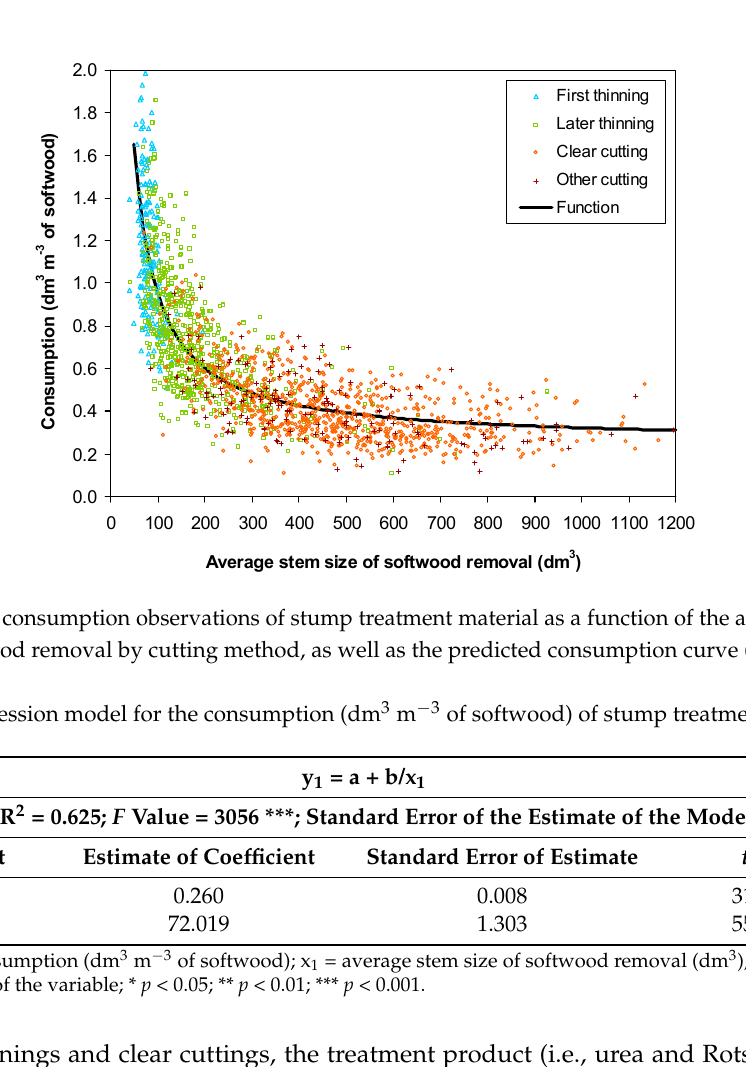
Table 3. The average consumption of stump treatment material by cutting method in the study.